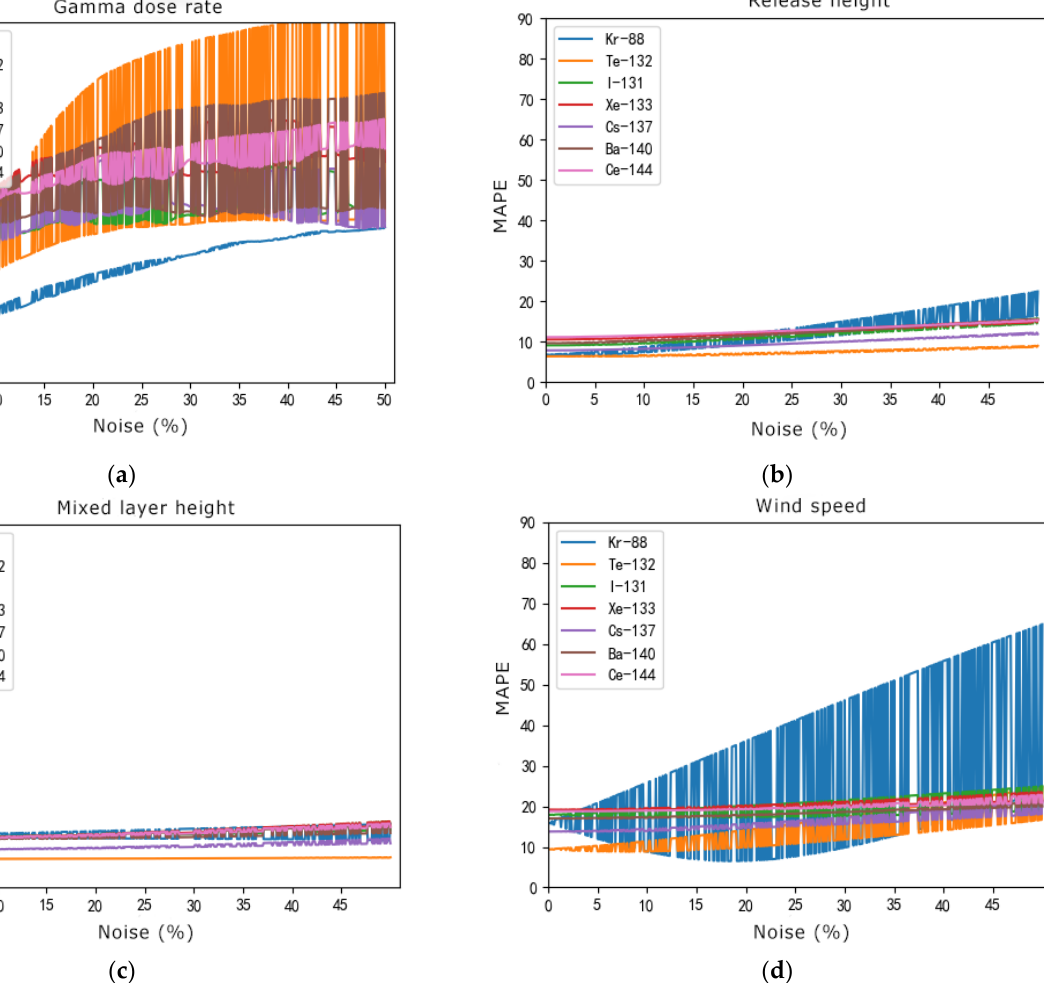
Figure 13. Noise analysis of input data. ( a ) Gamma dose rate; ( b ) Release height; ( c ) Mixed layer height; ( d ) Wind speed.